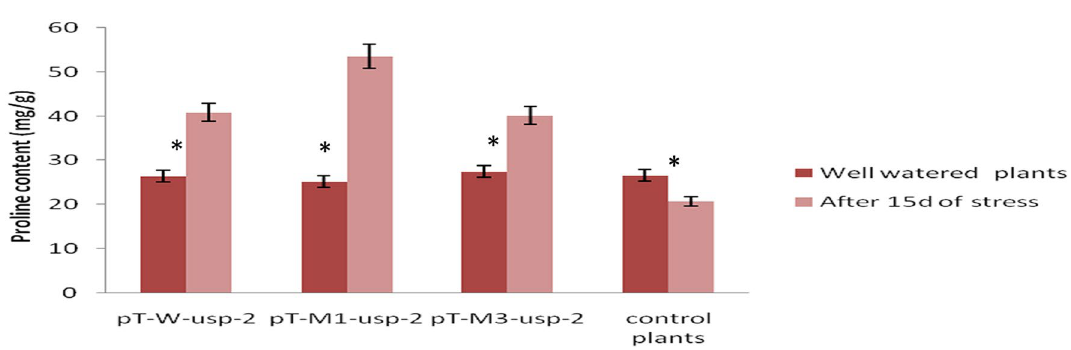
Figure 16. Comparison of Proline content from pT- W-usp-2 , pT- M1-usp-2 , pT- M3-usp-2 plants under control and drought stress